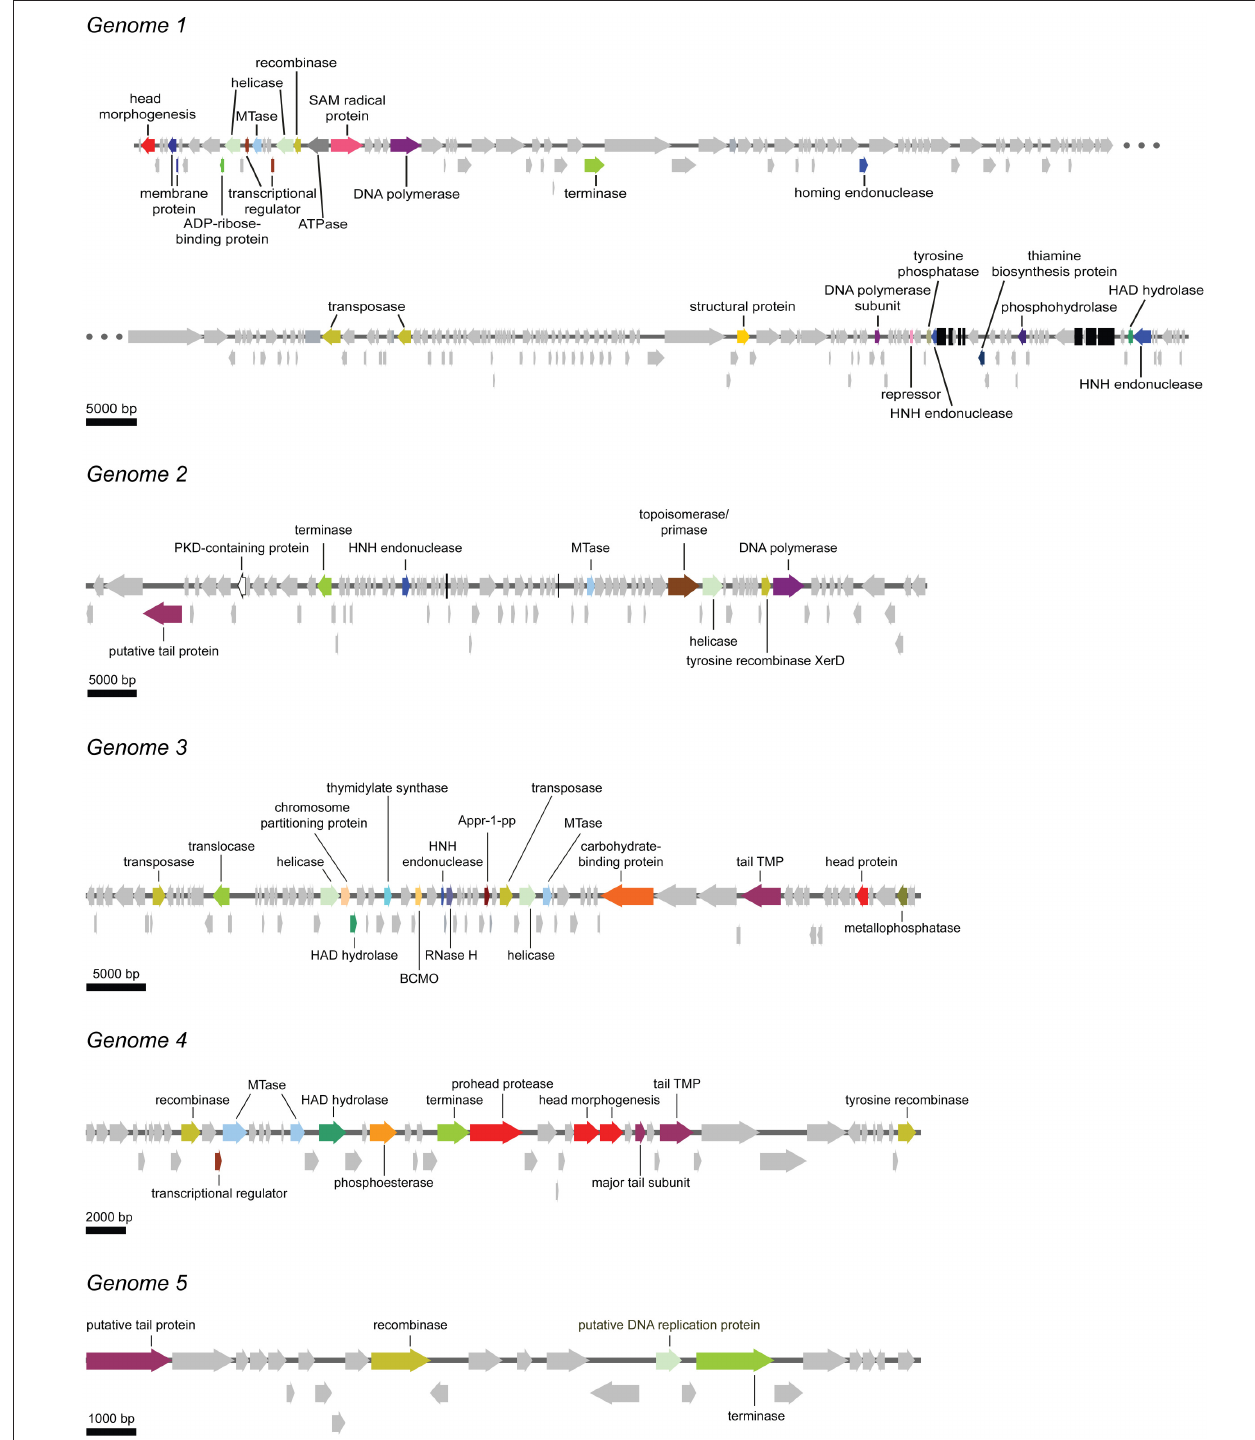
Frontiers in Microbiology | www.frontiersin.org